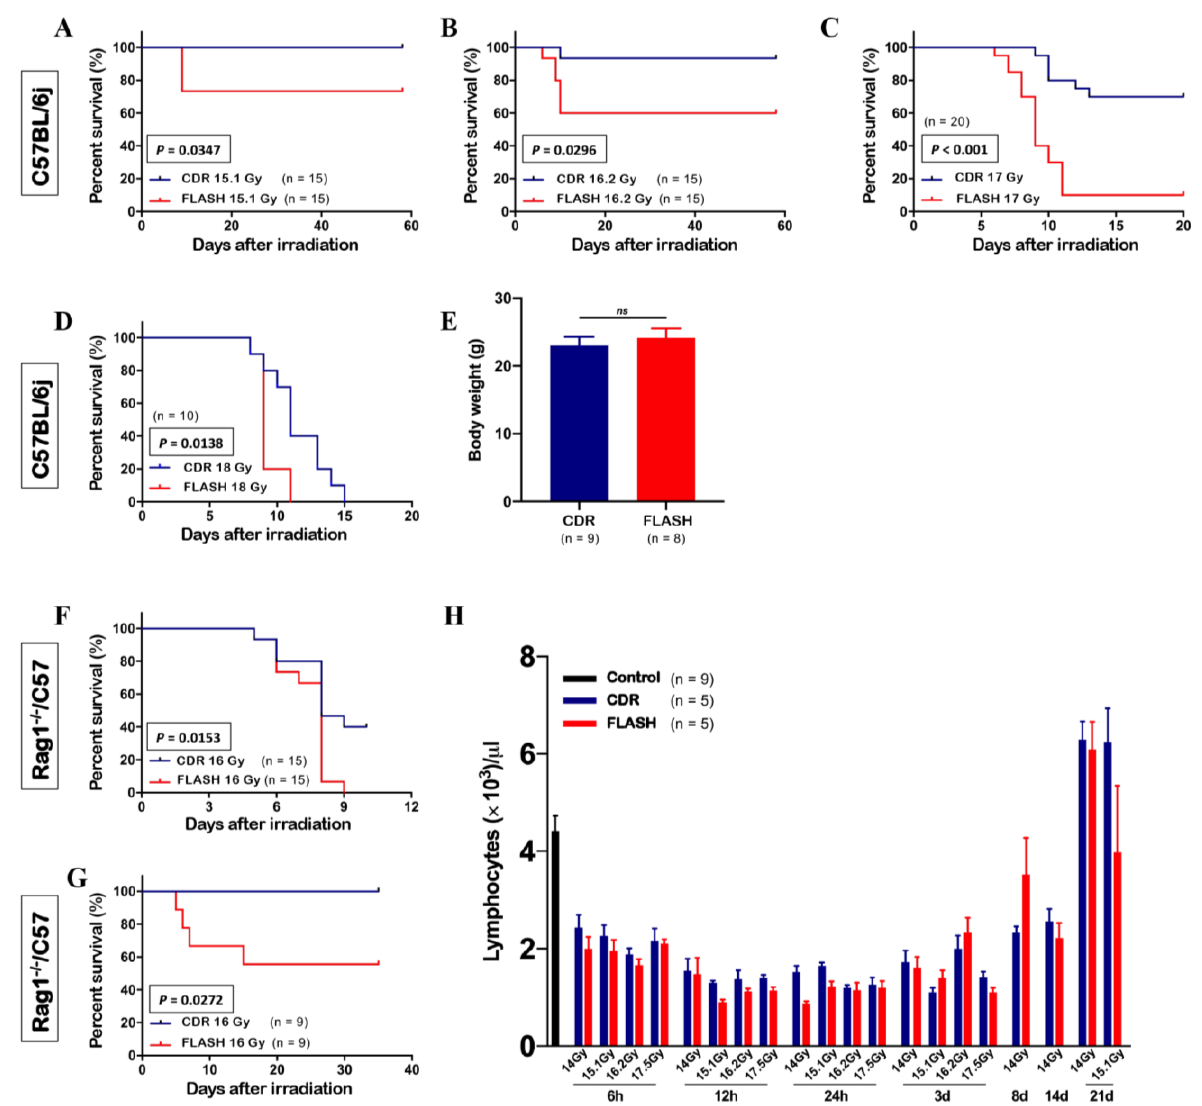
Figure 1. ( A – H ) Survival curves of C57BL/6j mice after FLASH and CDR irradiation at different dose levels: ( A ) 15.1 Gy; ( B ) 16.2 Gy; ( C ) 17 Gy; ( D ) 18 Gy. ( E ) Body weight of C57BL/6j mice at 280 days post exposure. ( F , G ) Survival curves of Rag1 − / − /C57 mice with different body weights (( F ) 18.8g; ( G ) 24.5 g) following 16 Gy irradiation. ( H ) Number of circulating lymphocytes in C57BL/6j mice at different timepoints. ns, not significant.